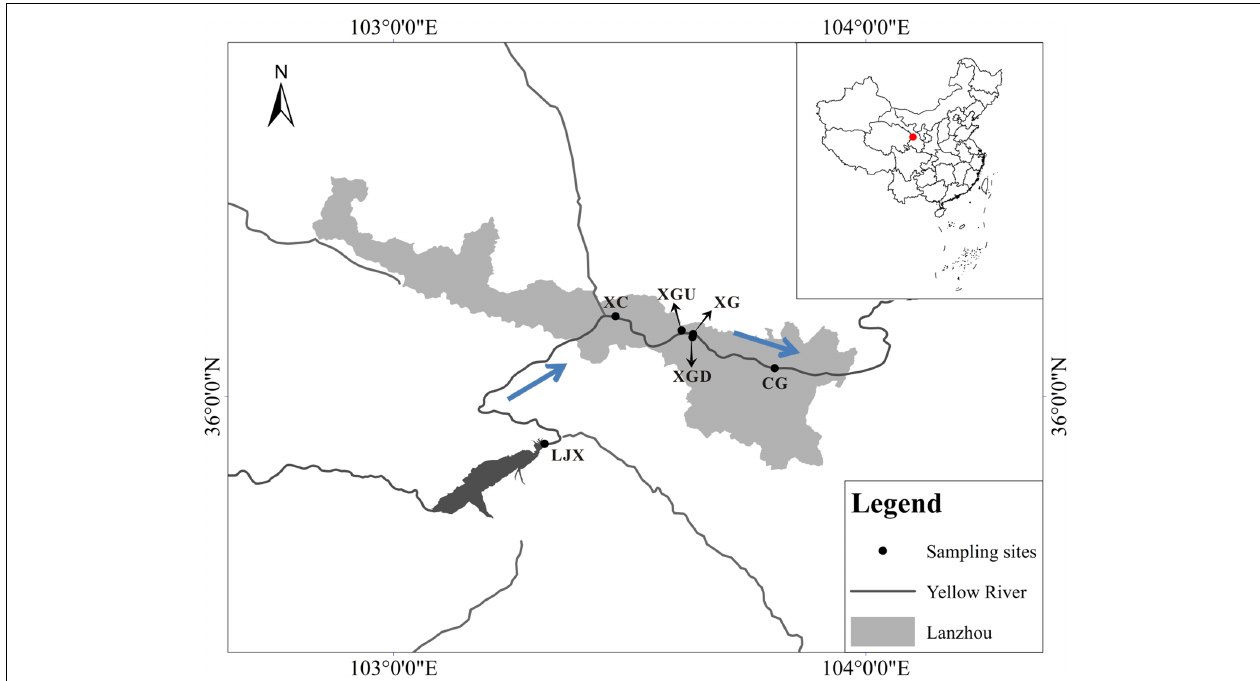
FIGURE 1 | Location of sampling sites along the Gansu industrial reach of the Yellow River. Three categories are uncontaminated regions – Xincheng district (XC) and upstream of Xigu district (XGU), slightly contaminated regions - downstream of Xigu district (XGD) and the Liujiaxia reservoir (LJX) and heavily contaminated regions - Xigu district (XG) and Chengguan district (CG). The arrows indicated the flowing direction of the Yellow